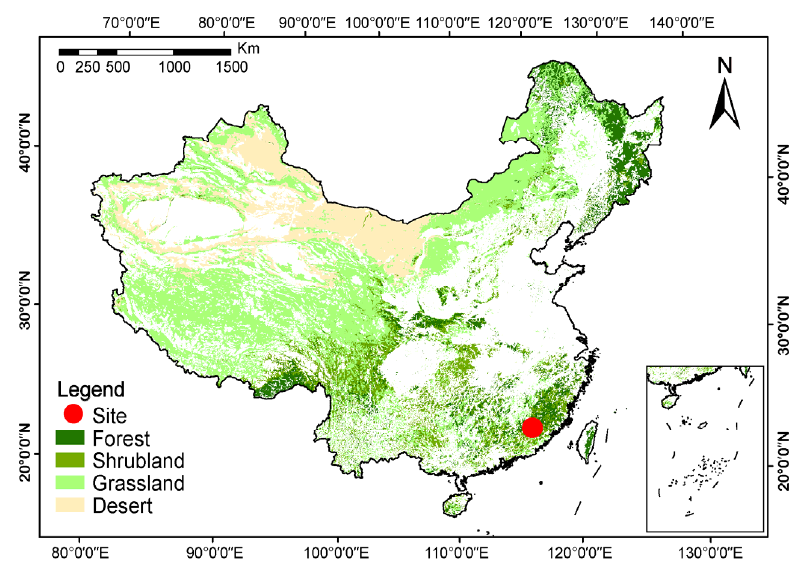
Figure 1. Map of the study area. We sampled from two multispecies restoration modes, two P. massoniana plantations (20-year plantation, PM, and 40-year overmature plantation, PO) and a 40-year secondary forest (SF). One restoration mode is the transformation of the coniferous plantation using local broadleaf trees including Mytilaria laosensis , Liquidambar formosana , Quercus acutissima , Michelia macclurei , Castanopsis hystrix , and Ilex chinensis (BF). The other mode is replenish- ment with broadleaf trees ( M. laosenis , L. formosana , M. macclurei , and C. hyperix ) under the coniferous canopy (PB). Schima superba , L. formosana , Syzygium buxifolium , and I. pubescens are the common trees in the